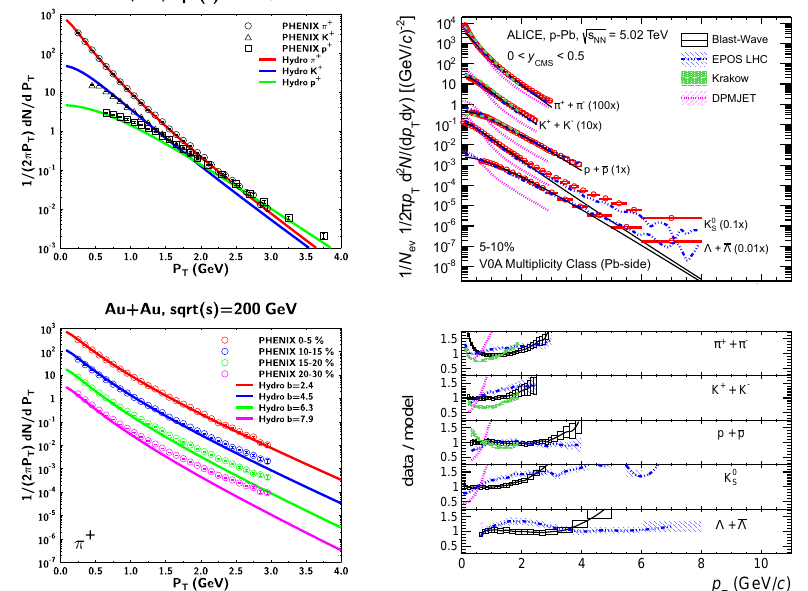
Figure 9. Left : Transverse momentum spectra of pions, kaons, and protons emitted into the incident √ s lead nucleus hemisphere (0 < y cms < 0.5) in 5%–10% most central p + Pb collisions at = 5.02 TeV. NN Data ( red circles) are compared to two microscopic models: EPOS LHC [168], DPMJET [167], to the hydrodynamics calculation [170], and to the Blast-Wave fit with formula Equation (53). Reproduced from Ref. [176]; Right : Comparison of the experimental p T -spectra of π + , K + , and √ = 200 GeV and ( bottom ) (for the case of π + ) of their p + from Au + Au collisions at ( top ) s NN centrality dependence [177] with the hydrodynamical model calculations. Reproduced from Ref.